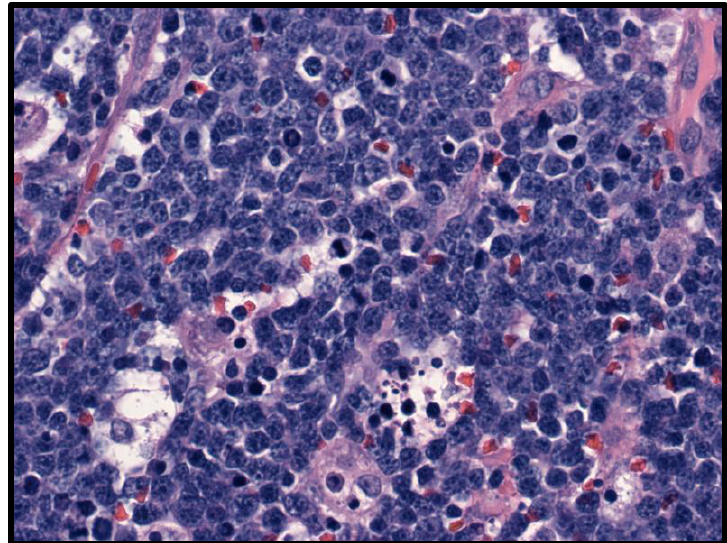
Figure 3. High-grade B-cell lymphoma with 11q aberration/large B-cell lymphoma with 11q aberration often shows morphologic features similar to Burkitt lymphoma, as seen here. However, these lesions are genetically different from Burkitt lymphoma, containing proximal interstitial gains and telomeric losses in the q arm of chromosome 11, while lacking MYC rearrangements and genomic alterations in the ID3 – TCF3 complex (hematoxylin and eosin stain, 60× original magnification).